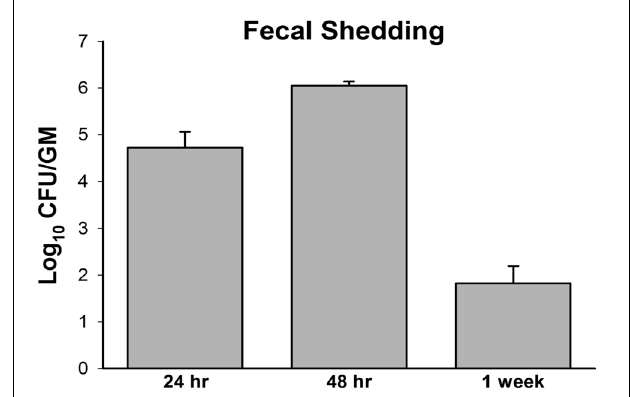
FIGURE 2 | M. avium subsp. paratuberculosis shedding in mouse fecal samples. Pooled fecal samples were collected from mice orally infected with two consecutive doses of 10 9 CFU of M. avium subsp. paratuberculosis K10 Samples were decontaminated by HPC treatment and serial dilution plating on 7H10 agar was performed for quantification. All samples were run in